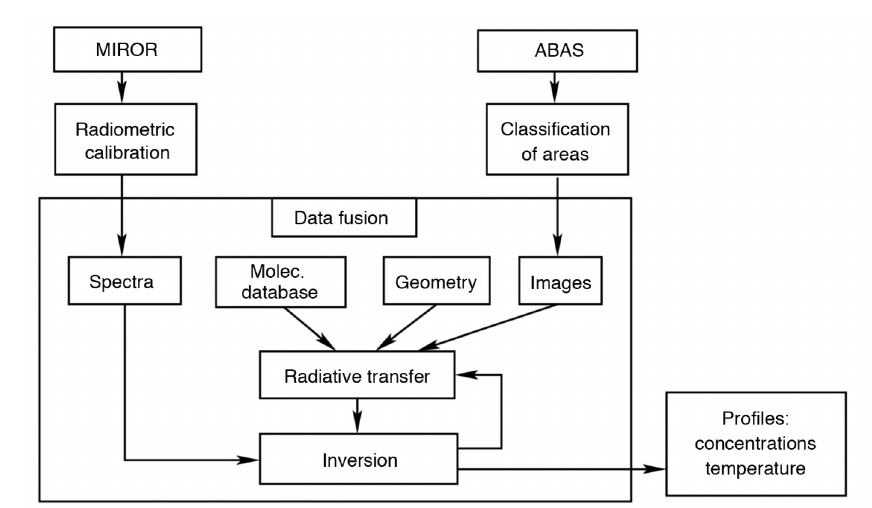
Fig. 6. Schematic visualizing the FASA data fusion